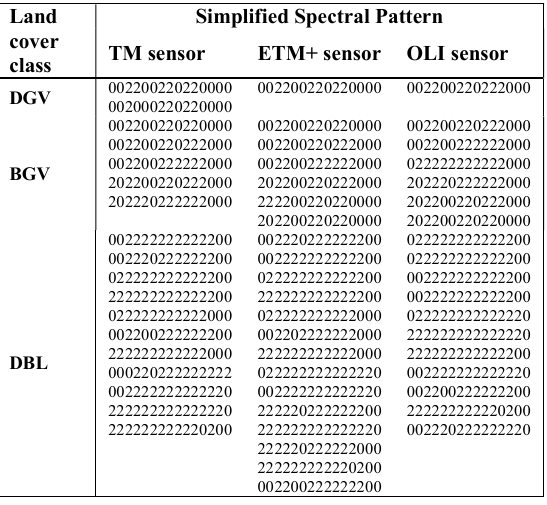
Table 1. Examples of SSPs for three land cover classes DGV- dark green vegetation, BGV-bright green vegetation